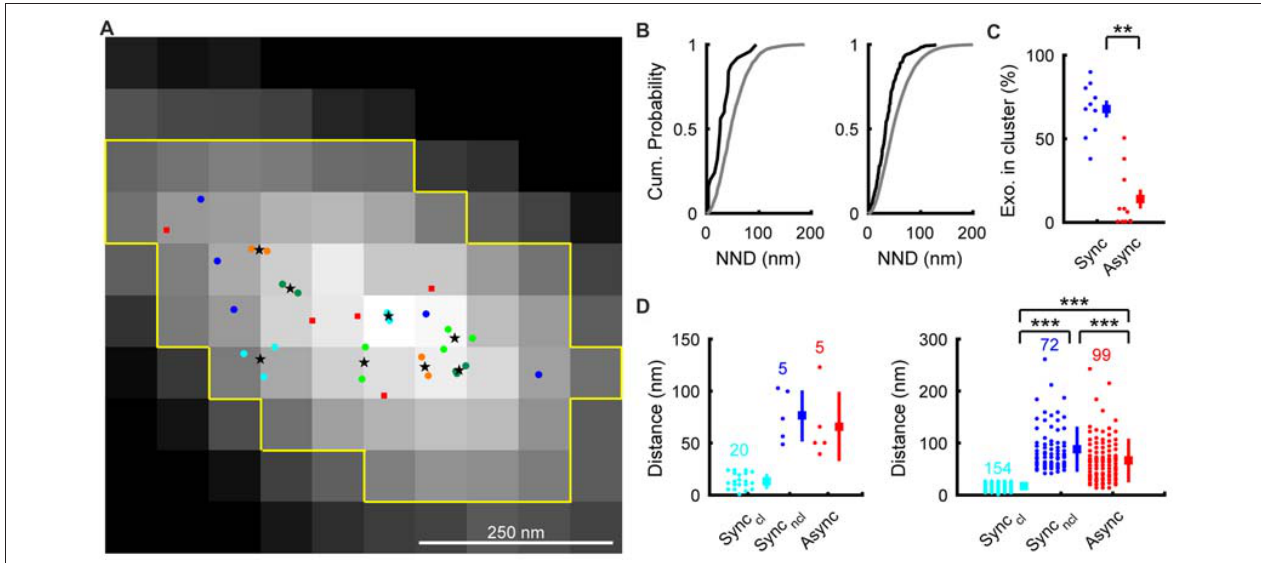
FIGURE 3 | Distribution of synchronous and asynchronous release locations in an AZLM. (A) Distribution of synchronous and asynchronous release locations in a representative AZLM. The AZLM area defined using the Otsu method was marked with yellow lines. Synchronous release events are categorized as those that occurred in clusters (marked with light blue, yellow green, dark green or orange circles) and those that occurred outside of any clusters (dark blue circles). Centers of individual cluster are marked with black stars. Asynchronous release locations are marked with red squares. (B) Cumulative probability plots of the nearest neighbor distances (NND) between synchronous release locations (black) and those obtained by Monte-Carlo simulation assuming random distribution (gray). The left graph shows data obtained from the AZLM shown in (A) , and the right one shows averaged data from all AZLMs. (C) Ratios of synchronous (dark blue) or asynchronous (red) release events occurring in synchronous release clusters in each AZLM. Small circles represent percentages in respective AZLMs and a square and a bar represent mean and SEM. ∗∗ p < 0.01, U-test. (D) Distribution of distances between each release location and the nearest center of a synchronous release cluster (light blue, synchronous release in a cluster; dark blue, synchronous release outside of any clusters; red, asynchronous release). The left graph shows data obtained from the AZLM shown in (A) , and the right one shows data from all AZLMs. Small circles represent individual data and a square and a bar represent mean and SD, respectively. Numbers in the graph indicate the numbers of respective release locations. ∗∗∗ p < 0.001, U-test with Bonferroni